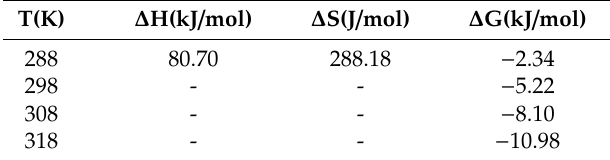
Table 6. Thermodynamic parameters for the adsorption of Cr(VI) on SDS-modified chitosan beads.